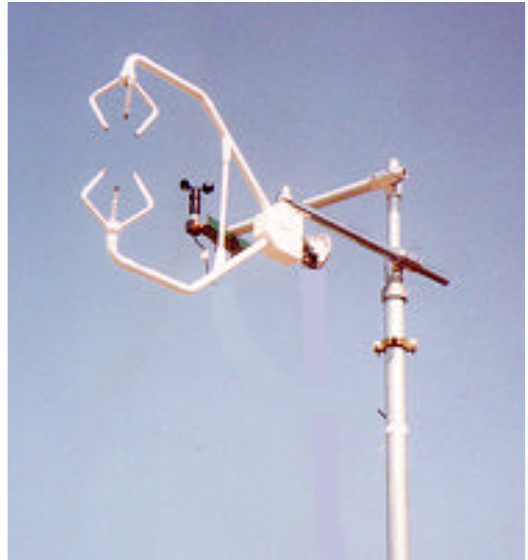
Fig. 3. Experimental mast including the sonic and the NKE cup anemometers. Heights 20 to 25m above ground and 3.3m above the laboratory’s building